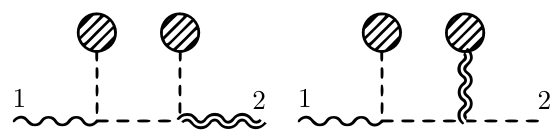
Figure 5 . An example of two diagrams with hard scalar